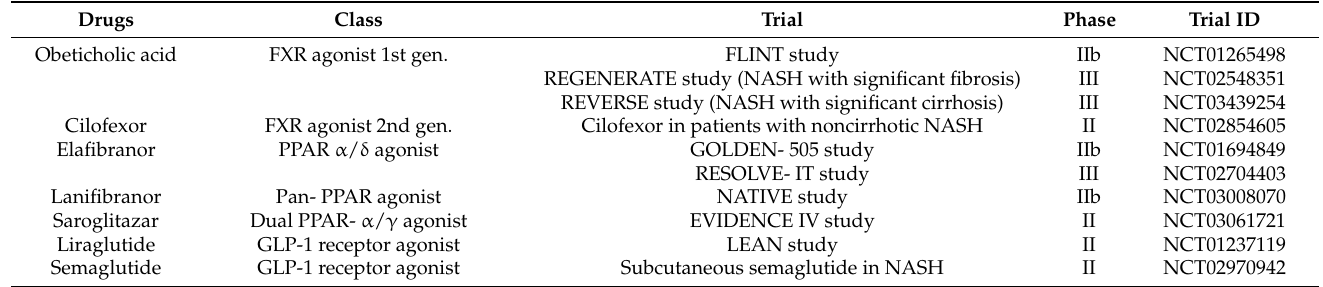
Figure 2. Graphic representation of principal therapeutic strategies in MAFLD. Table 1. Summary of ongoing clinical trials on new drug therapies for NASH resolution. FXR: Farnesoid X receptor; PPAR: Peroxisome proliferator-activated receptor; GLP-1: Glucagon-like